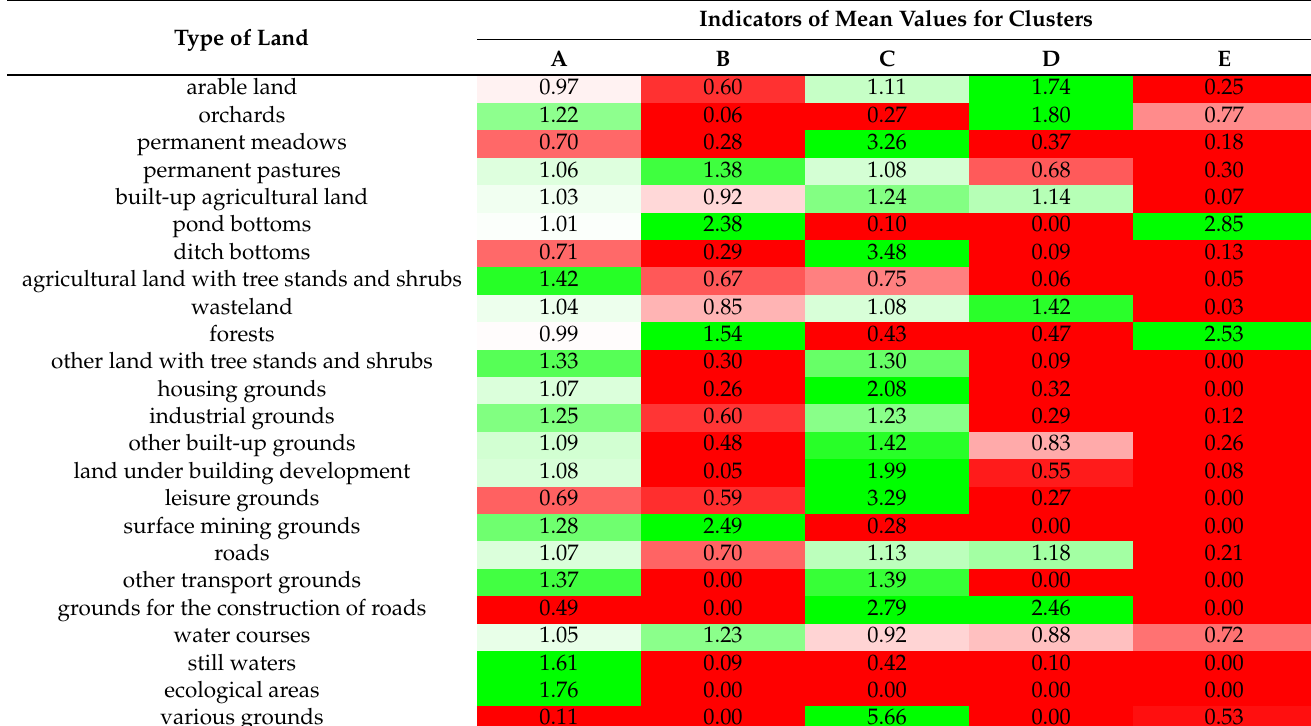
Table 3. Values of indicators for identified